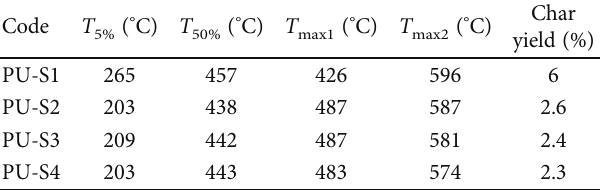
Figure 14: TGA-DTG of PURF